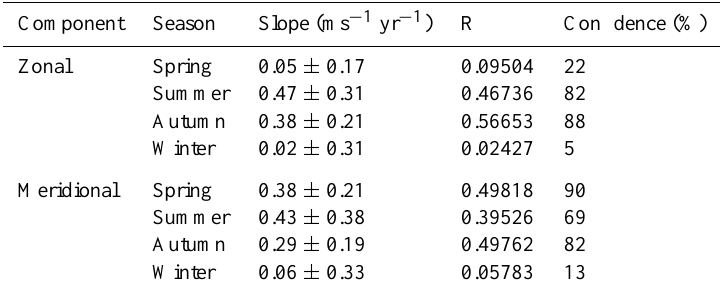
Table 2. Gradients and errors, correlation coefficients and confidence level (Fisher’s Z transformation) of best-fit straight lines fitted to seasonal winds over the interval of